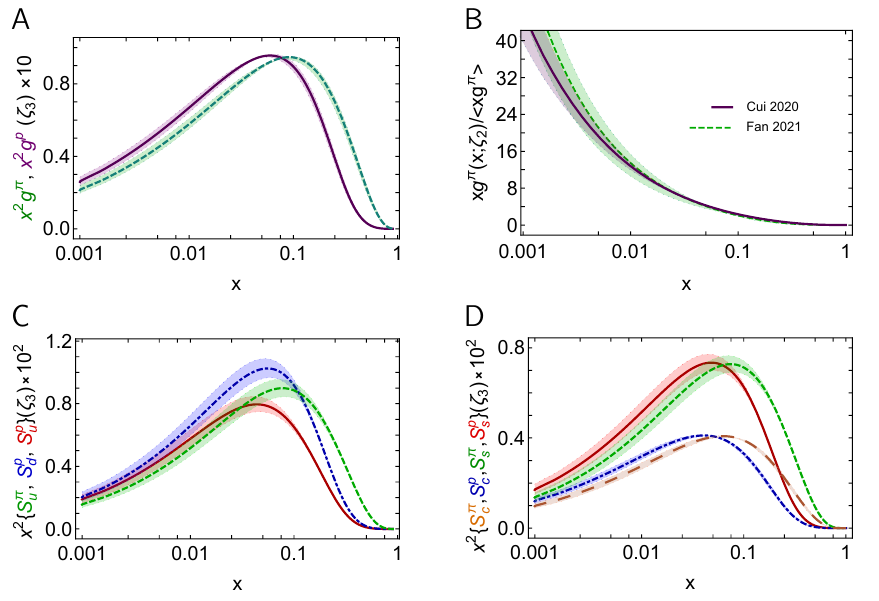
Figure 25. Left upper panel ( A ): Glue DFs— x 2 g , in the proton (solid purple curve) and pion (dashed green curve) at ζ = ζ 3 . Right upper panel ( B ): Comparison between continuum [127] (Cui2020) and lattice [433] (Fan2021) results for the glue-in-pion DF at ζ = 2GeV. Left lower panel ( C ): Pro- ton and pion light quark sea DFs: x 2 S p u ( x ; ζ 3 ) —solid red curve; x 2 S p x 2 S π u ( x ; ζ 3 ) —dotted-dashed green curve. Right lower panel ( D ): Proton and pion c - and s quark sea DFs: x 2 S p s ( x ; ζ 3 ) —solid red curve; x 2 S π s ( x ; ζ 3 ) —dashed green curve; x 2 S p c ( x ; ζ 3 ) —dotted-dashed blue curve; x 2 S π c ( x ; ζ 3 ) —long-dashed orange curve. The band surrounding each CSM curve ex- presses the response to a ± 5% variation in ζ H . The uncertainty in the lQCD result is similarly indicated in Panel B .